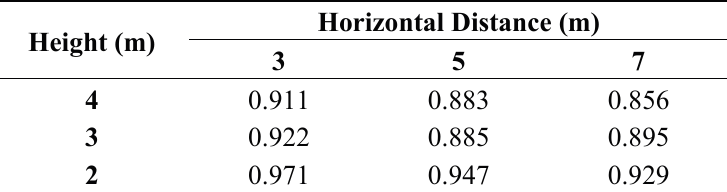
Table 3. Coefficients of determination (R 2 ) according to horizontal and vertical distance from machine. Overall values for three measurement sections (A, B, C) and three fan settings (1.5, 3,